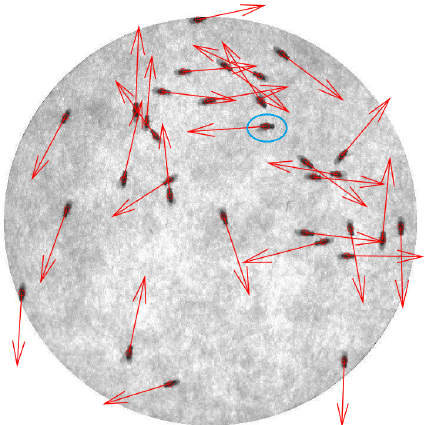
Figure 13. The result of determining the heading direction of each fly using Video_1. The heading direction of each fly is shown as a red arrow. Almost all heading directions were correctly determined except the fly with the blue circle.